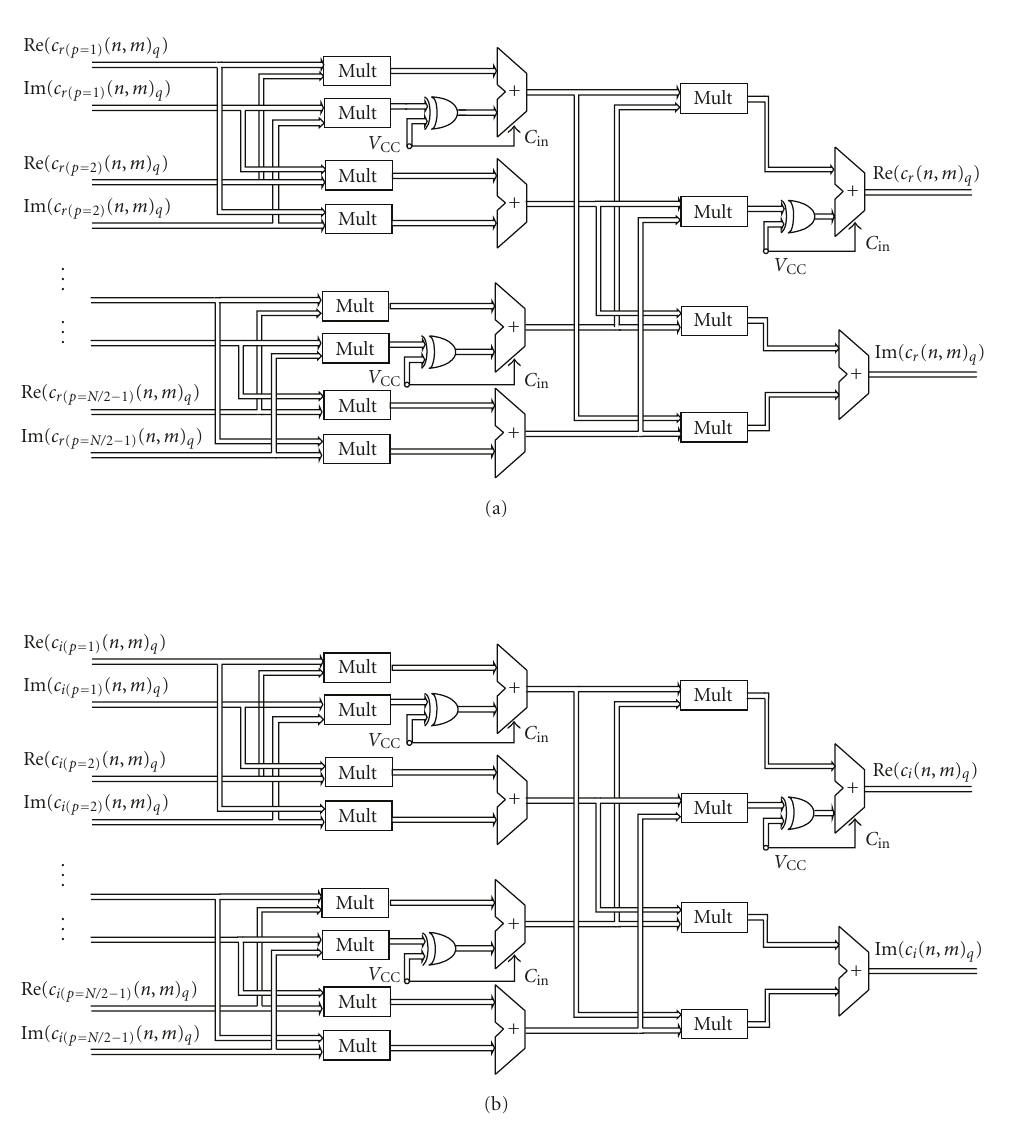
Figure 5: Architecture for realization of concentration functions for the q th signal component: (a) c r ( n , m )